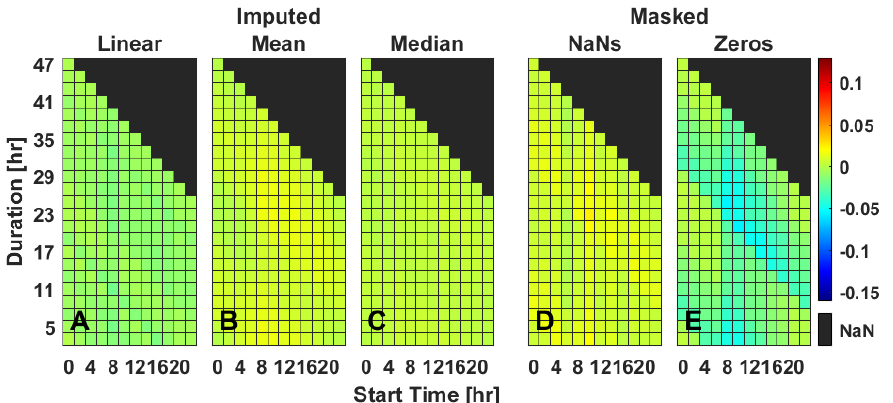
Figure 3. Rhythm regularity (IS) for two gaps (gap 1: 115 min, gap 2: 140 min) of missing data starting on a representative day (Tuesday). Data are the mean difference between the masked and true IS values ( D , E ) or imputed and true IS values ( A – C ), as extracted from Bland–Altman plots. Three different imputation methods [linear interpolation ( A ), mean ToD ( B ), median ToD ( C )] and two masking methods [NaNs ( D ), zeros ( E )] are presented for varied durations between bouts ( y -axis) and timings ( x -axis) of masked data gaps. Values are color-coded as indicated with best performance being closer to 0; NaN values indicate where values could not be calculated due to dataset constraints. For heat maps of each individual day of rhythm regularity, see Supplemental Data Figure